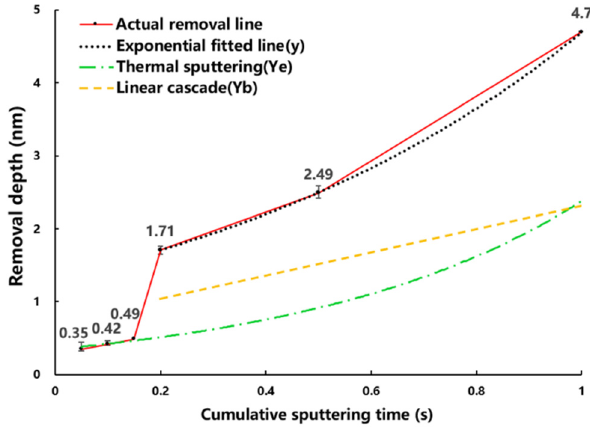
Figure 4. Relationship between removal depth and accumulated sputtering time (below 0.2 s).